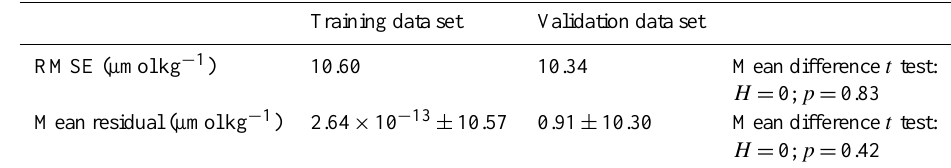
Table 2. Mean difference t test for the A T algorithm between the training and validation data sets